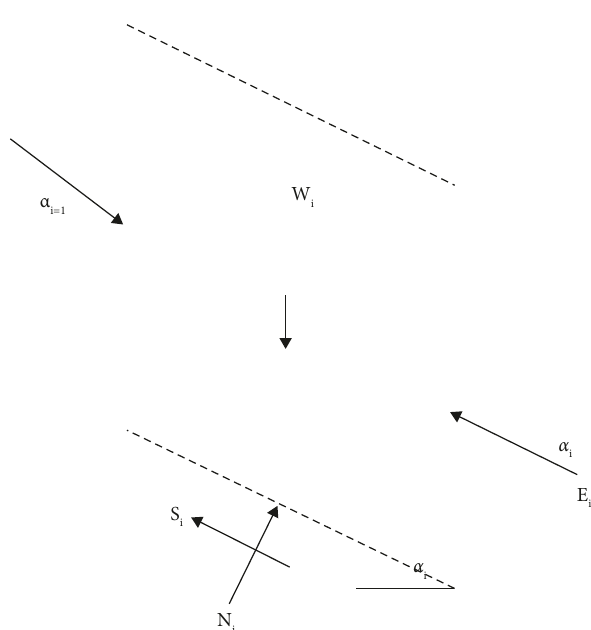
Figure 5: Diagram of the fundamental force system acting on block I